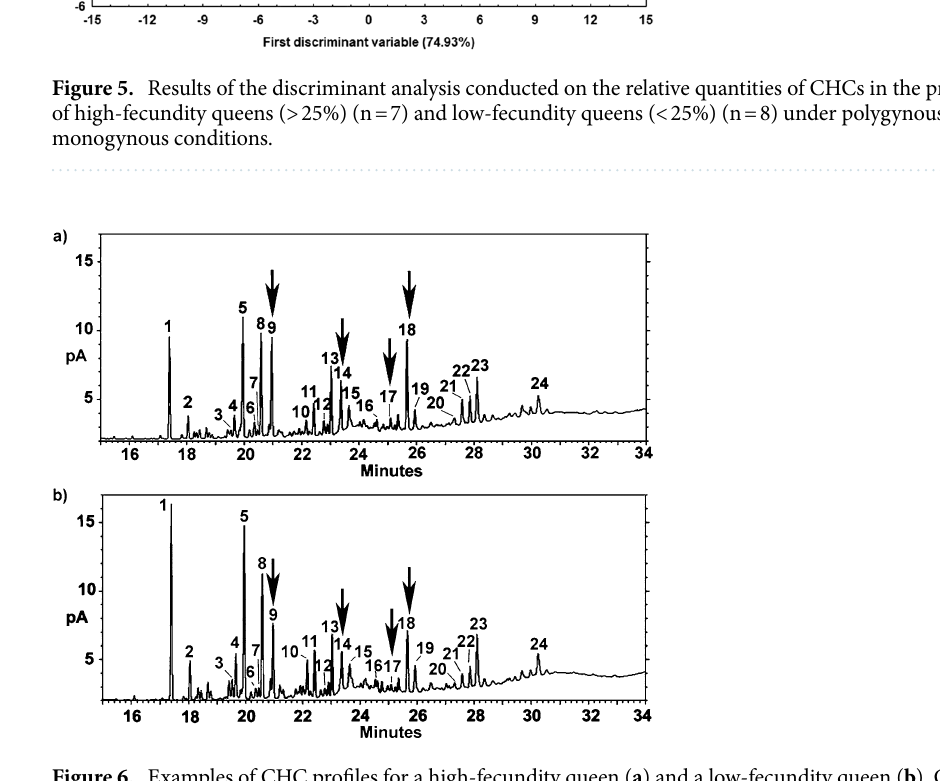
Figure 6. Examples of CHC profiles for a high-fecundity queen ( a ) and a low-fecundity queen ( b ). Compound names are provided in Table 2. The arrows indicate the compounds 5,11-diMeC 29 ; 5, 11-diMeC 31 ; 11-MeC 33 ; and 5,11-diMeC 33